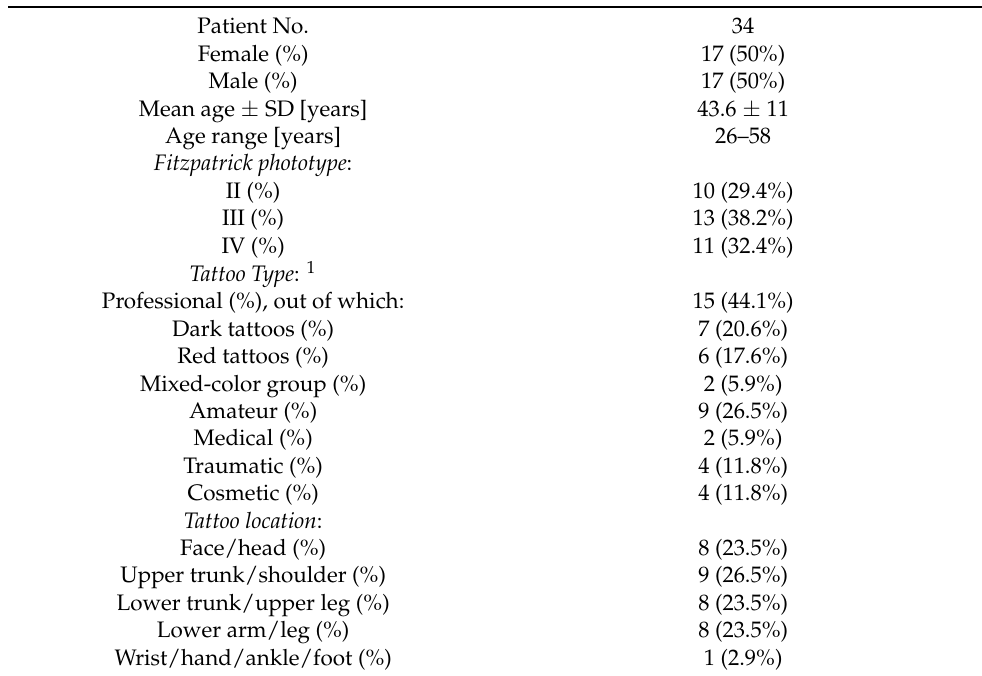
Table 2. Demographic data of included patients.